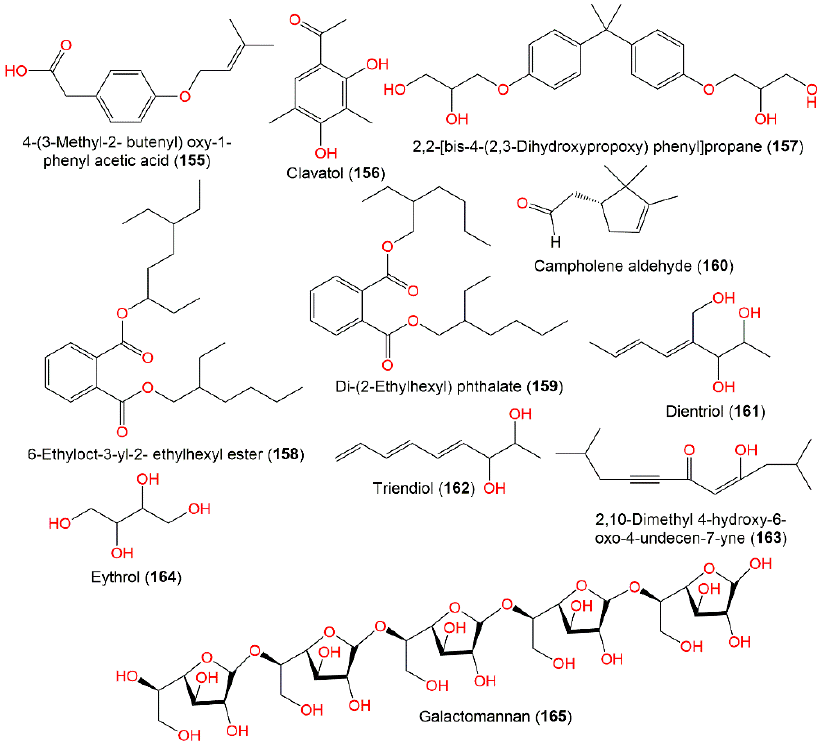
Figure 15. Other metabolites ( 155 – 165 ) reported from A. ochraceus.